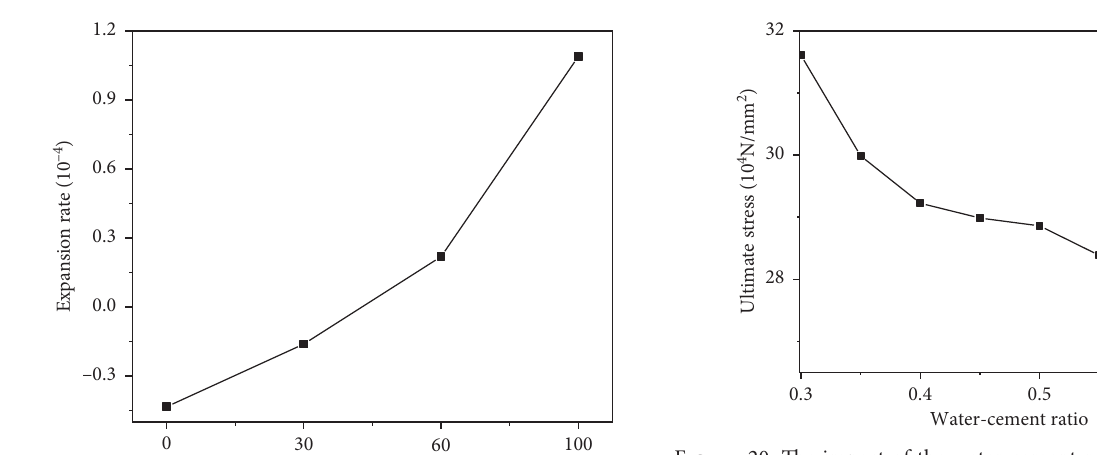
Figure 20: The impact of the water-cement ratio on the ultimate stress of the FSSAC stub